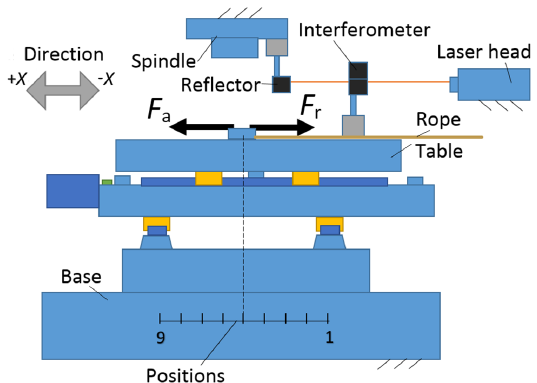
Figure 3. Measurement layout in the X axis direction on the sliding (cross) table of the milling machine.